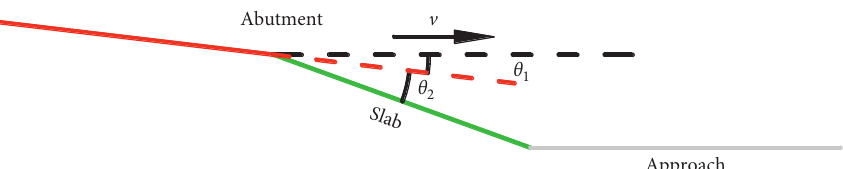
Figure 11: Transition section model when slabs are installed.